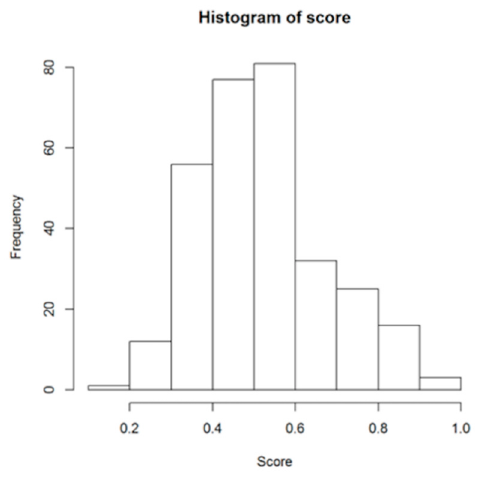
Figure 1. Histogram of average score distribution. The model estimation result suggests that, ceteris paribus, the expected score of a dentist with a qualification in dentistry is 0.058 greater (almost one correct answer more) than in the case of a medicine qualification. There is a significant correlation between score and qualification, 0.144, p = 0.012 (Figure 2).